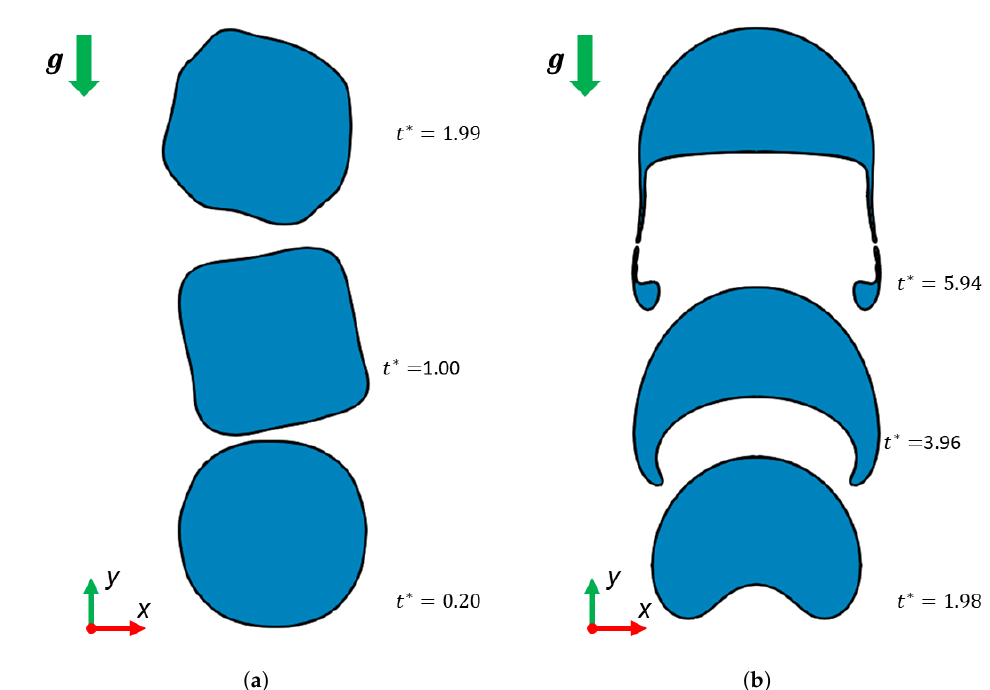
Figure 15. B1 ( a ) and B2 ( b ) He bubbles in PbLi represented through contour r α =